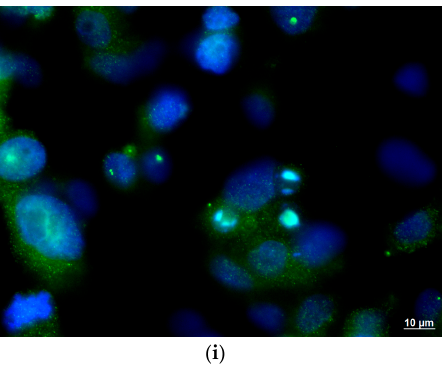
Figure 2. Indirect immunofluorescence of MA-104 cell culture infected with Wa rotavirus (RVA) of inoculum and monkeys’ faeces, showing rotavirus infection pattern with granular and cytoplasmatic fluorescence in cell monolayer. ( a ) RVA inoculum administrated in monkeys (3.1 × 10 6 FFU/mL). ( b ) V7 monkey faeces at 6 dpi (control monkey). ( c ) T7 monkey faeces at 7 dpi. ( d ) U13 monkey faeces at 6 dpi. ( e ) Z7 monkey faeces at 7 dpi. ( f ) X9 monkey faeces at 6 dpi. ( g ) AA7 monkey faeces at 6 dpi. ( h ) AB7 monkey faeces at 5 dpi. ( i ) V11 monkey faeces at 7 dpi. Wa RVA antigen (VP6) was stained in green (Alexa Fluor ® 488 nm) and nucleus were stained in blue with DAPI (4 ′ ,6-diamidino-2- phenylindole).